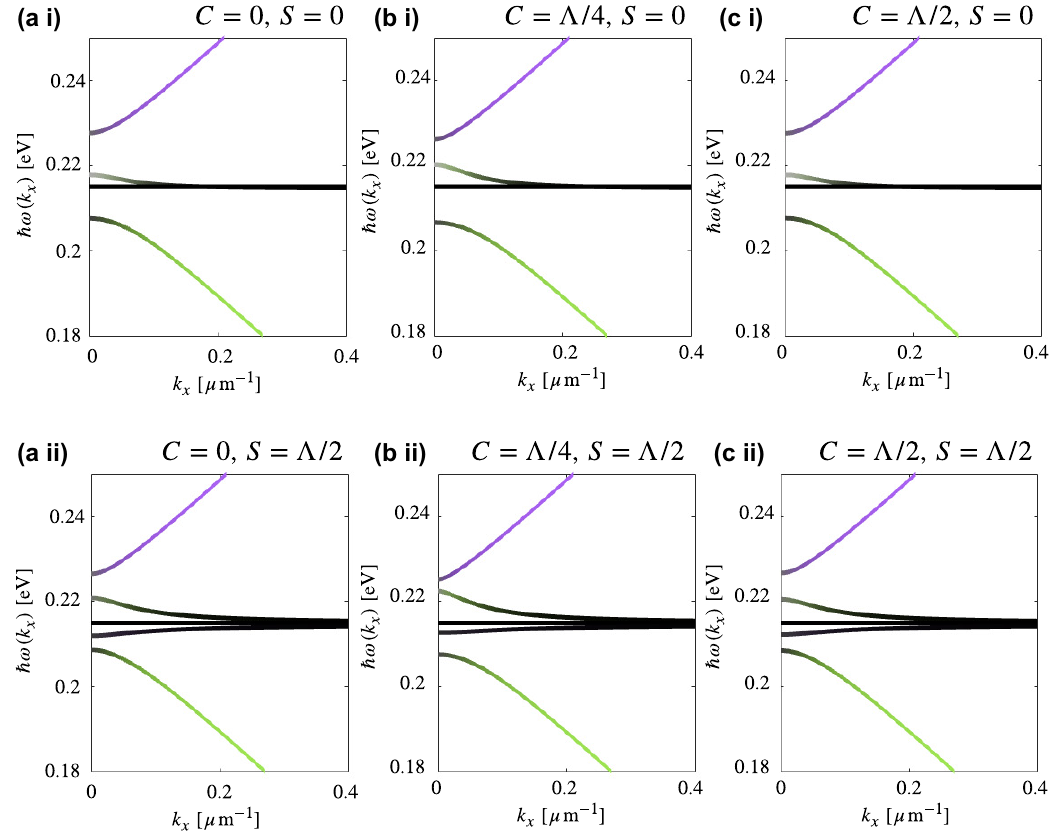
Figure 7: Dependency of bands on position of molecules at partial filling: Dispersion relations for molecular distributions centred (in the first grating period) about (a) C = mod[ x , Λ ] = 0 with spread (i) S = 0 and (ii) S = Λ∕ 2, (b) C = Λ∕ 4 with spread (i) S = 0 and (ii) S = Λ∕ 2, and (c) C = Λ∕ 2 with spread (i) S = 0 and (ii) S = Λ∕